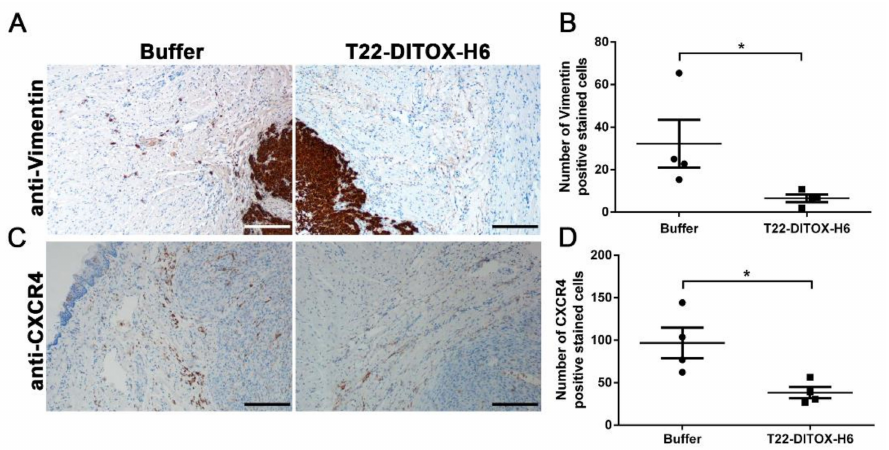
Figure 2. Anti-invasive T22-DITOX-H6 effect in the tumor front in a HNSCC orthotopic mouse model. ( A ) Representative human-vimentin IHC images of tumors collected from buffer- and T22-DITOX- H6-treated animals, showing a reduction in the number of human-vimentin-positive stained cells in the invasive front of the tumors after the nanotoxin treatment. Scale bar = 200 µ m. ( B ) Quantification of the number of human-vimentin-positive stained cells in the tumor budding in the control and nanotoxin-treated tumors. ( C ) CXCR4 IHC analysis of the invasive front of tumors derived from control and nanotoxin-treated mice, displaying a reduction in the number of CXCR4 + cells upon T22-DITOX-H6 treatment. Scale bar = 200 µ m. ( D ) Quantification of the number of CXCR4-positive stained cells in the aforementioned CXCR4 IHC images. * p < 0.05; n = 4 per group (total animal number 8). Statistical analysis was performed by Mann–Whitney test. Error bars indicate